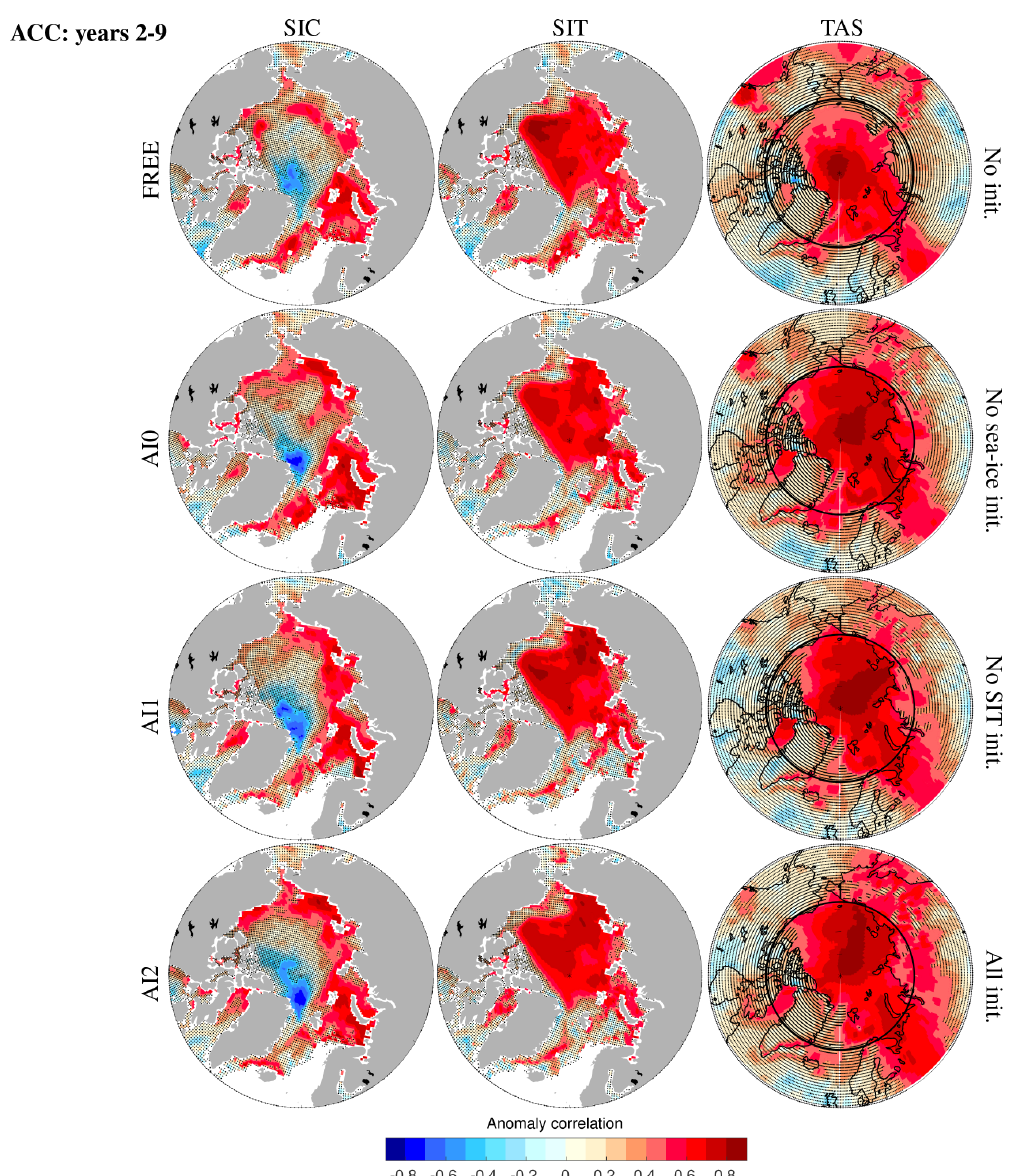
Figure 8. Same as Fig. 5 but for years